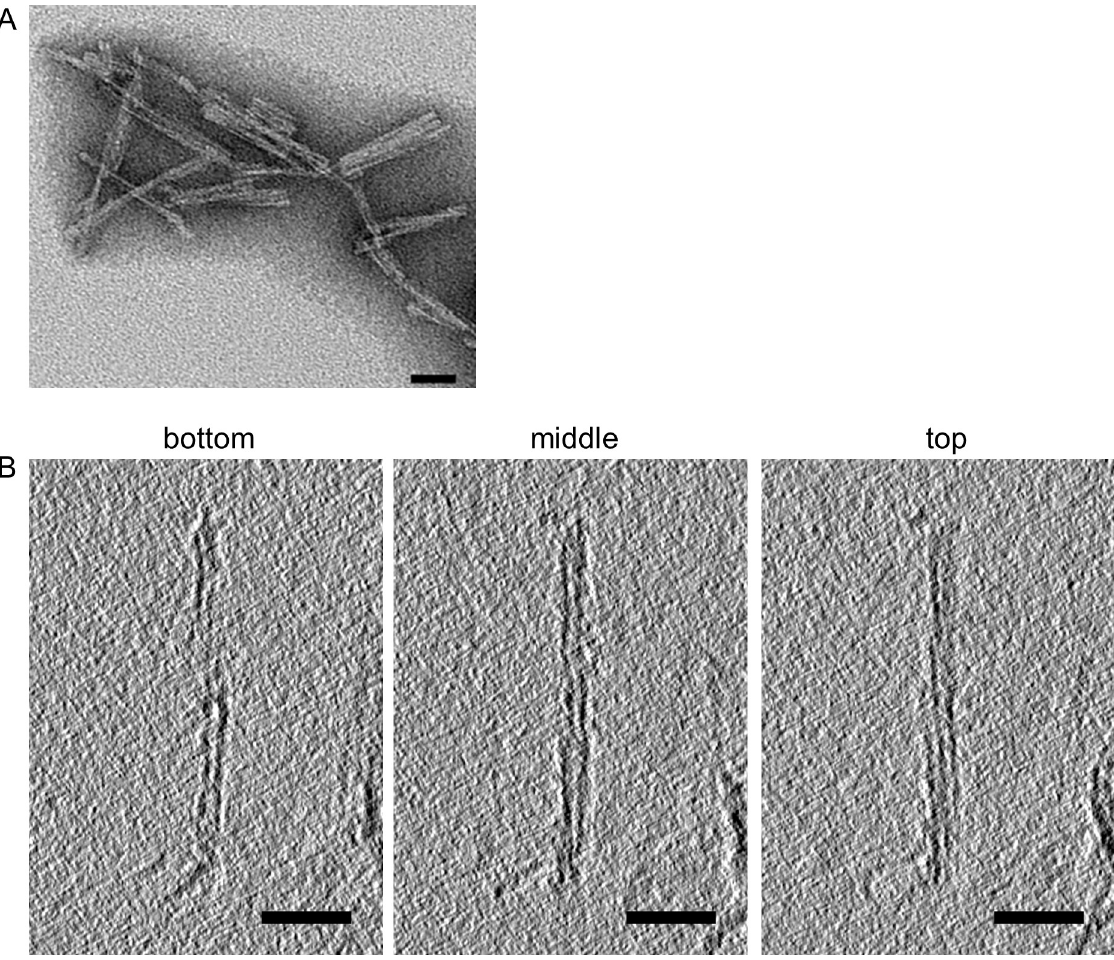
Fig 1. Negatively stained transmission (A) and cryo-electron tomography (B) of purified a22L prion preparation. In B, left-handed twist is evident in going from bottom to top tomographic slices through the fibril. Bars = 50